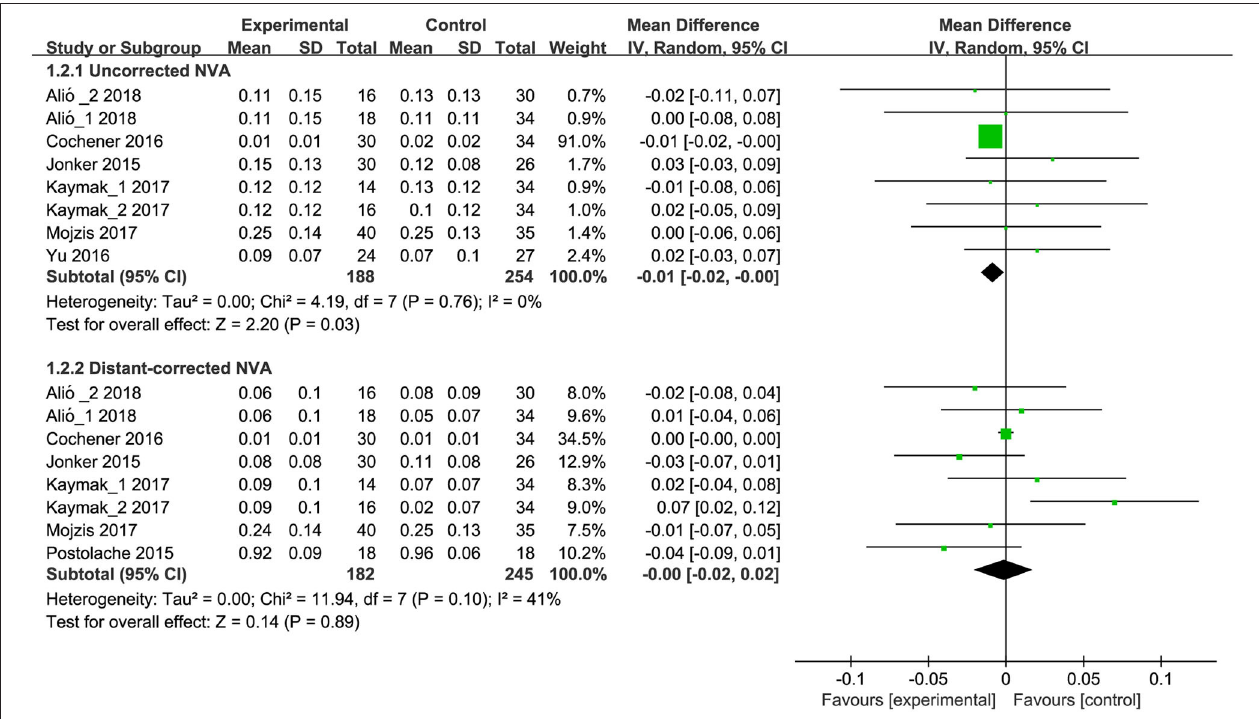
FIGURE 3 | Meta-analysis of NVA between trifocal and bifocal IOLs. SD, standard difference; IV, inverse variance; CI, confidence interval; NVA, near visual acuity. Experimental and control indicate trifocal and bifocal IOLs, respectively.